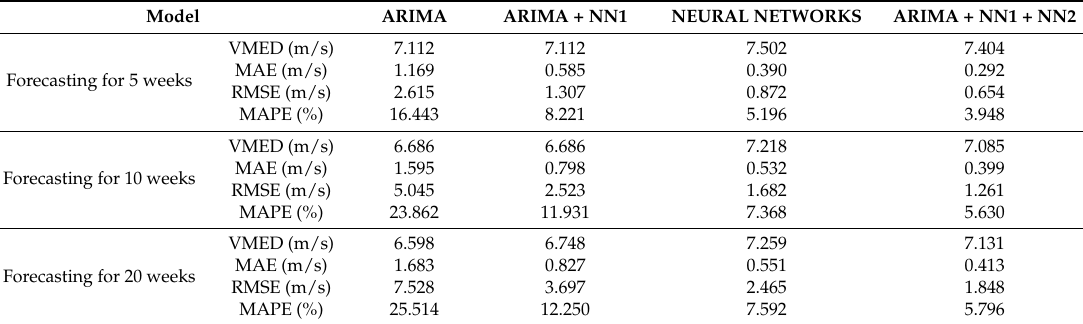
Table 6. Error of predicted speed for multi-step forecast—medium term (weeks). Model ARIMA ARIMA + NN1 NEURAL NETWORKS ARIMA + NN1 + NN2 Forecasting for 5 weeks